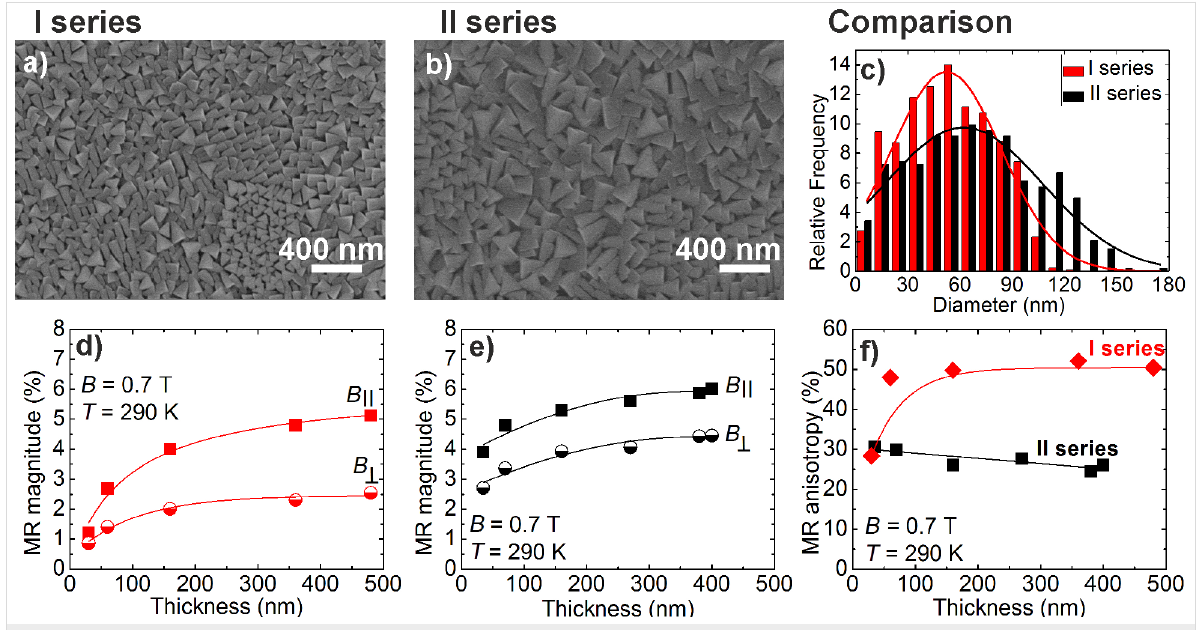
Figure 4: SEM picture of LSMO films grown from (a) one supply source - I series; (b) two supply sources - II series. (c) Comparison of relative fre- quency dependence on diameter of the crystallites for the I and II series 370 nm thick films. Magnetoresistance dependence on LSMO film thickness with applied external magnetic field of 0.7 T parallel ( B || ) and perpendicular ( B ) to the plane of the film grown from (d) one supply source and (e) two supply sources. (f) Magnetoresistance anisotropy dependence on film thickness for both deposition series. The lines are the guides for the eye.